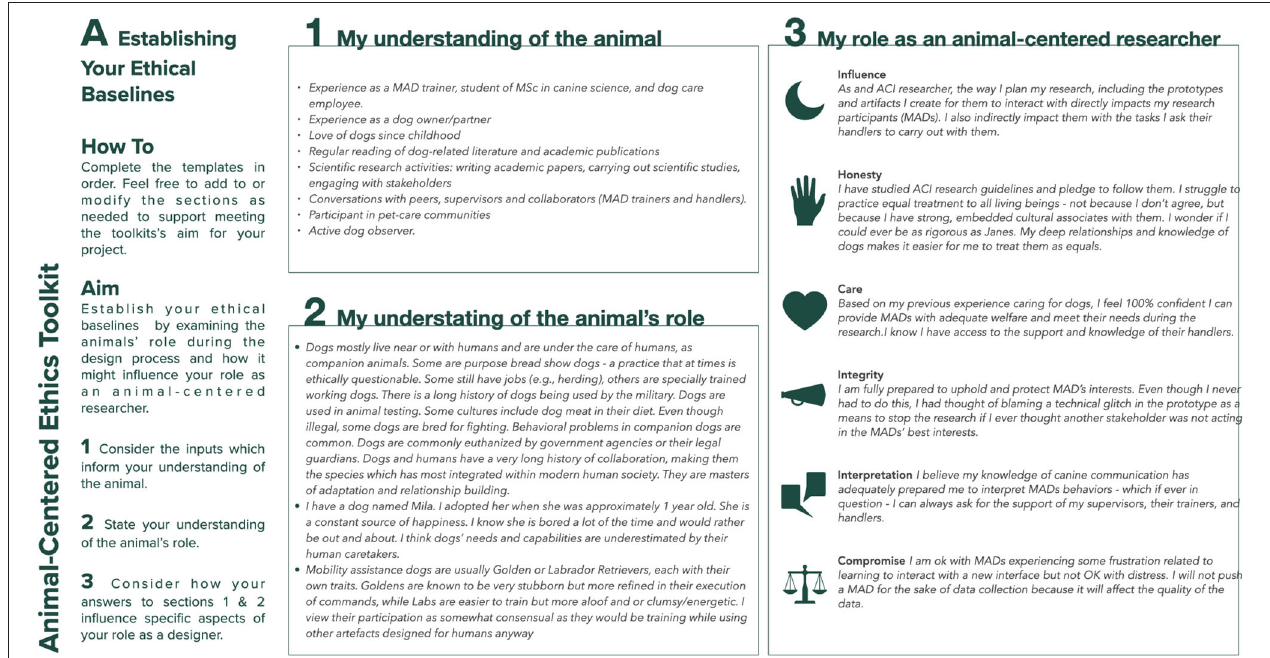
FIGURE 4 | Sample of template A: establishing your ethical baselines for the design of a set of canine-centric controls for Mobility Assistance